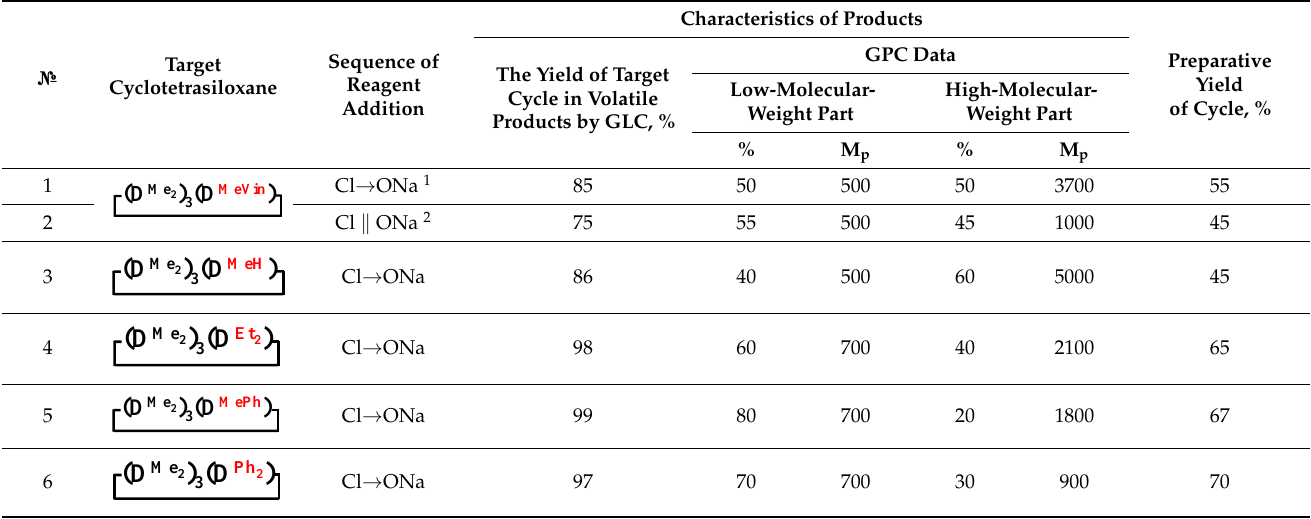
Table 1. Reaction conditions in THF and product characteristics.